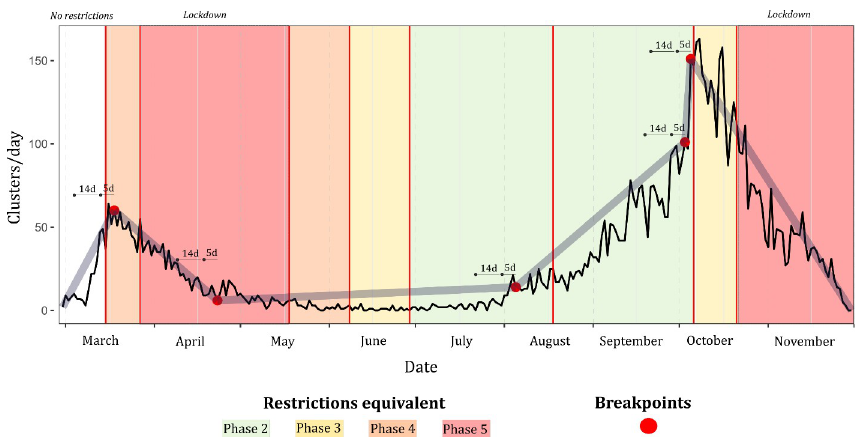
Fig 4. Breakpoint model (psi = 5) for notified COVID-19 clusters in the Republic of Ireland (based on first reported epi-date), February 29 th to November 30 th 2020.